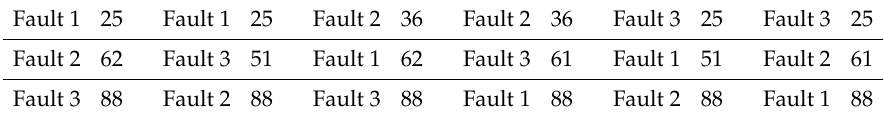
Table 2. Number of internal state bits revealed in function of the fault position used in